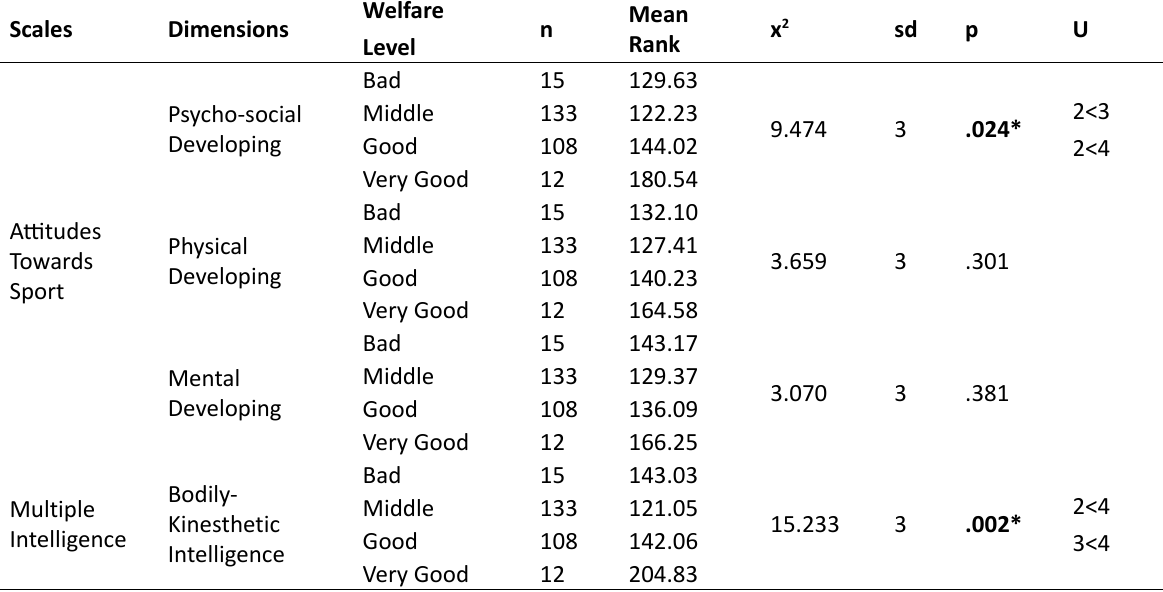
Table 7. Evaluation of the students’ attitudes towards sport and bodily-kinesthetic intelligence by welfare level